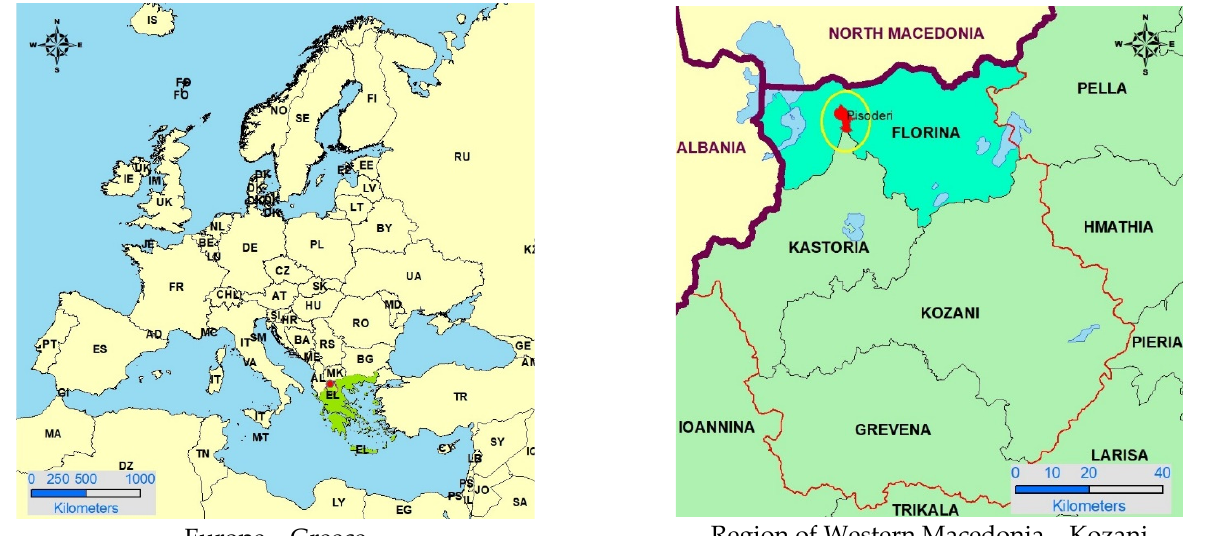
Figure 1. O rientatio map of Pisoderio co ‐ owned forest. Figure 1. Orientatio map of Pisoderio co-owned